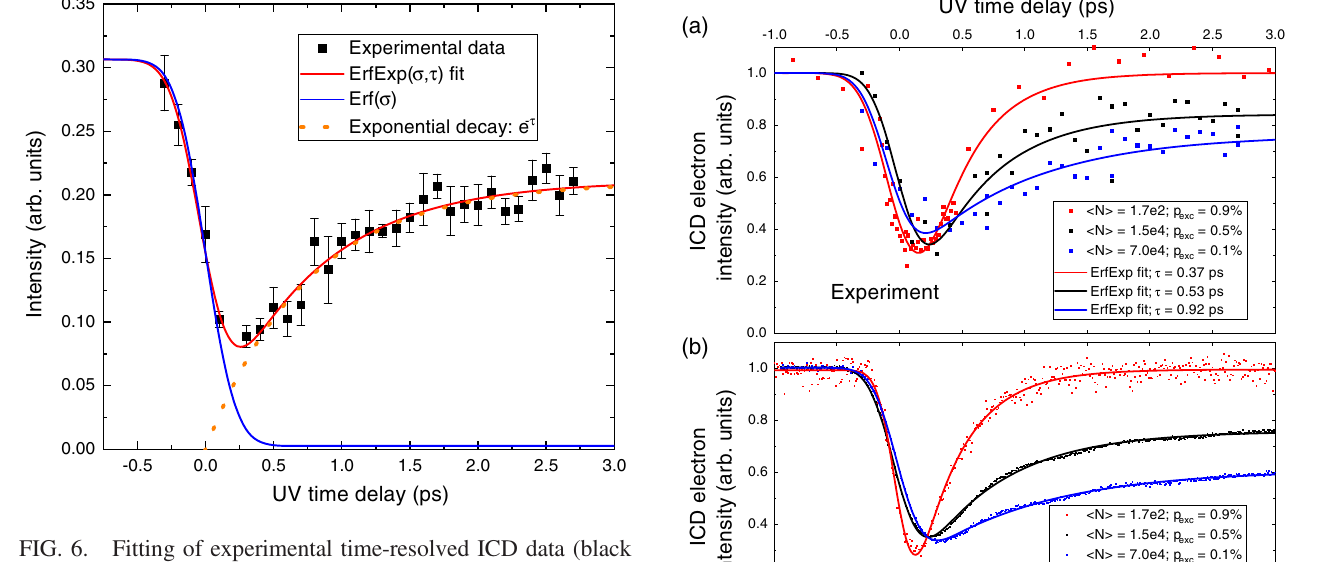
FIG. 6. Fitting of experimental time-resolved ICD data (black squares) with the function from Eq. (B1) (red curve). The components of the fit are illustrated separately: error function (blue curve) and exponential decay (orange dotted line).